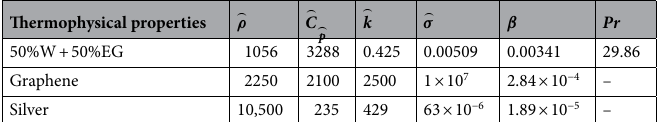
Thermophysical properties ⌢ ρ